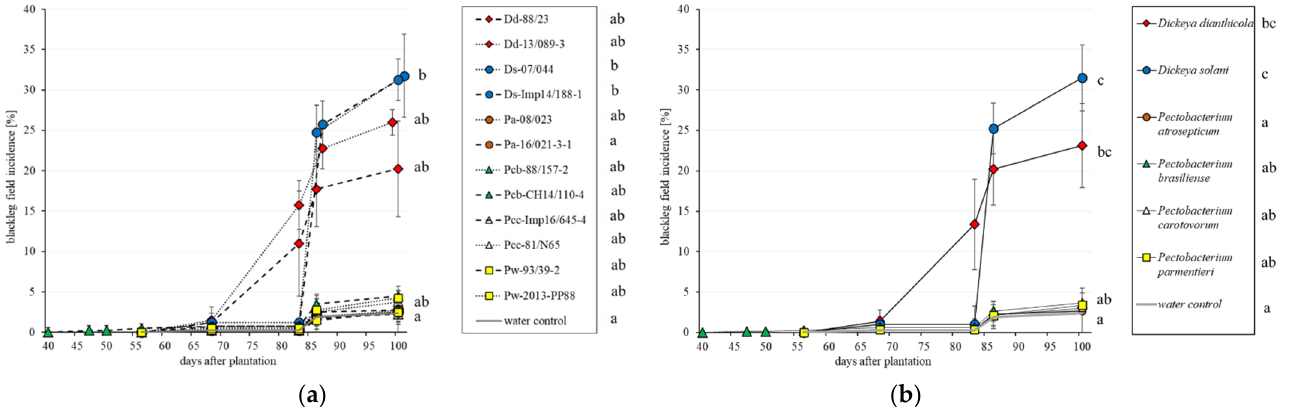
Figure 3. Timelines of the observed blackleg field incidence for the different 12 strains ( a ) and the different 6 species ( b ), average of two strains of similar color, in the field assay for 2020. Each single value of the timeline is the mean of four repetitions of 100 observed plants, with standard deviation bars. Different letters indicate statistical differences according to Kruskal-Wallis test (non-parametric-ANOVA based) of the mean incidence value between the strains at the last observation. In the chart, letters are grouped together. Details statistical differences between stains or species are given right to the legends. This is a repetition of the 2018 assay.